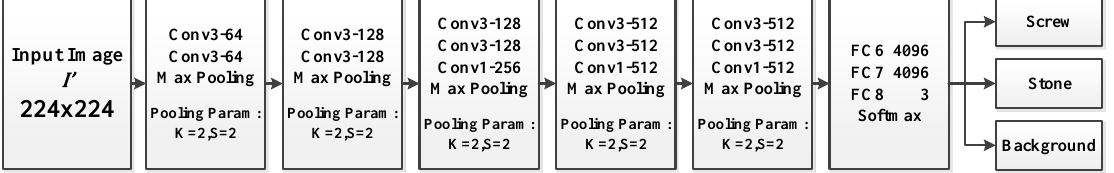
Figure 5. The FOD classification